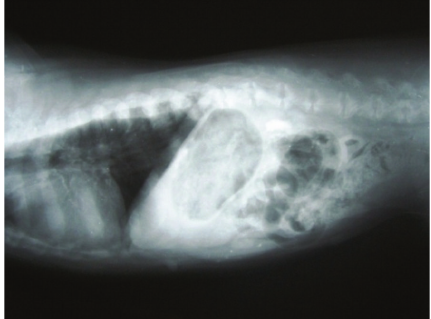
Figure 18: Ultrasonograph (2D) in sagittal scan of shrunk liver with hyperechoic hepatic parenchyma and irregular lobe margins surrounded with anechoic abdominal e ff usion in a 5-year-old intact male Cocker spaniel dog.